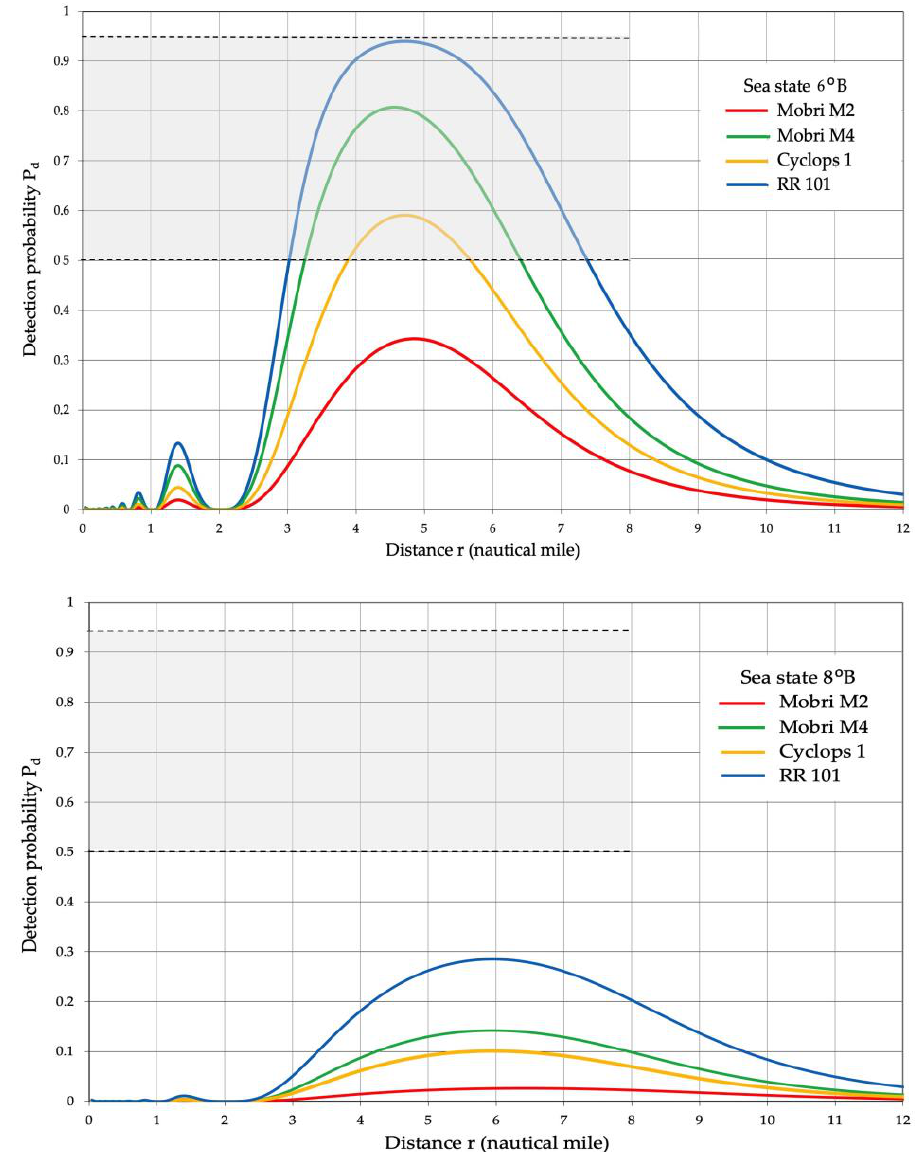
Figure 8. Detection probability of reflectors for Mobri M2, Mobri M4, Cyclops 1, and RR 101 at sea states of 0, 2, 4, 6, and 8